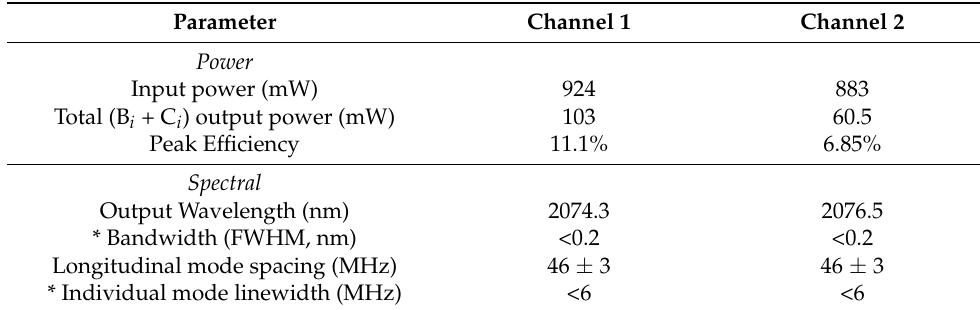
Table 3. Experimental parameters associated with each laser channel.